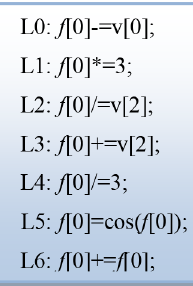
programFig. 2. A comparison of a GP program structure evolved by: a) LGP; b) Classical tree-based GP (after Gandomi et al.